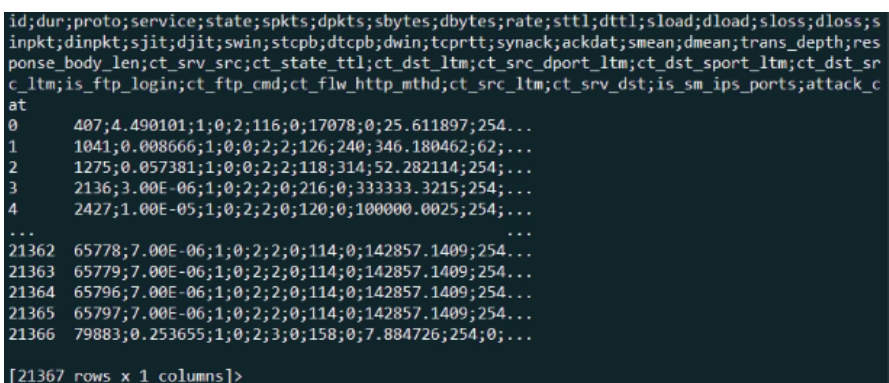
Figure A5. Sample of UNSW-NB15 dataset for DNS